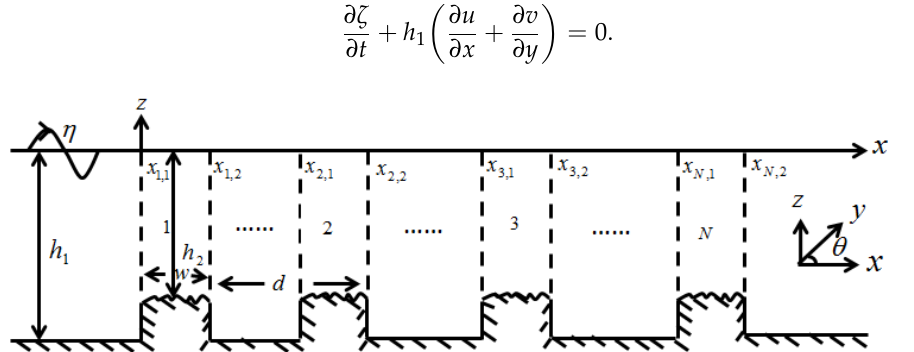
Figure 1. Schematic of wave motion over the non-smooth surface of rectangular